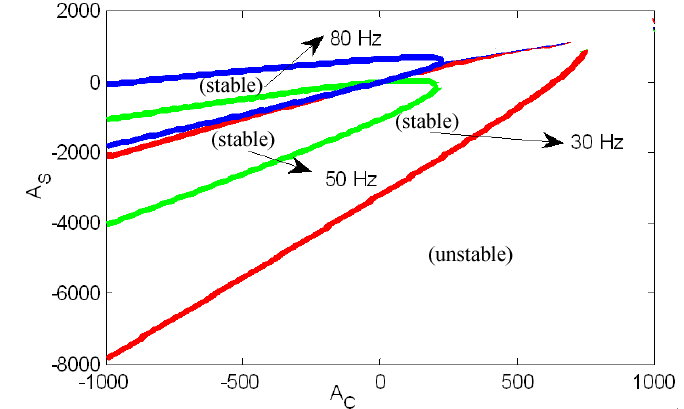
and A satisfying the critical stability under the different speed. C S